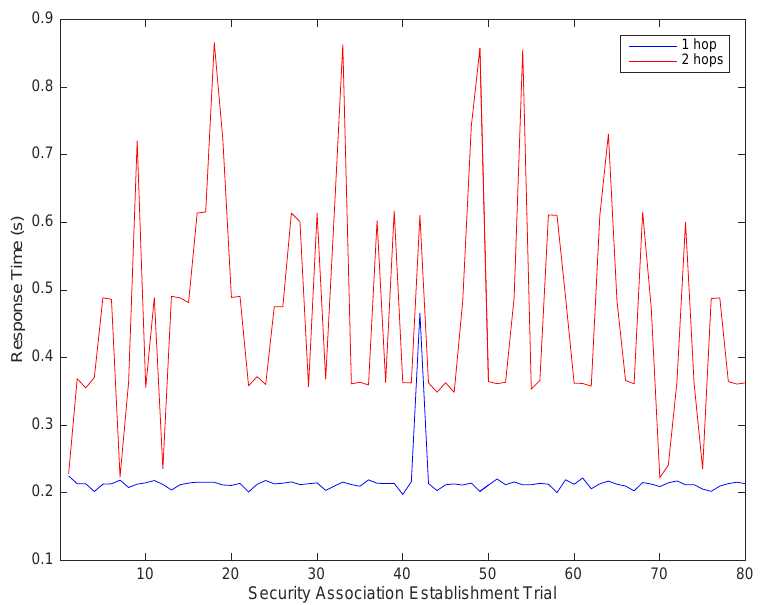
Figure 8. Response time of security association establishment considering two series of 80 requests with IS 1 in two network configurations: one and two hops.